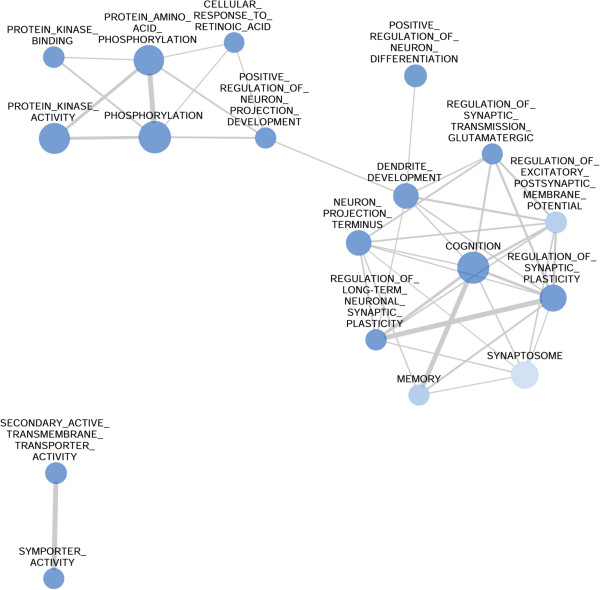
Network analysis of the GSEA results in the Hippocampus. The network shows significantly (nominal p < 0.05, false discovery rate < 0.25) enriched gene ontology (GO) terms in the gene set enrichment (GSEA) analysis in the hippocampus (HC) of Dark Agouti rats 3 weeks after a single-dose (15 mg/kg, intraperitoneal) 3,4-methylenedioxymethamphetamine (MDMA) administration. Blue circles represent the downregulation of the associated terms, while red circles would represent upregulations. The size of the nodes is proportional with the number of genes in the GO term and the thickness of the edges between lines represents the similarity coefficient. All processes in the HC are downregulated, and two well characterized groups of processes emerge. On one hand the processes related to cognition and memory, e.g. regulation of synaptic plasticity, dendrite development and regulation of glutamatergic synaptic transmission gene sets form diverse groups. On the other hand the processes related to kinase activity form another network. See text for further details.